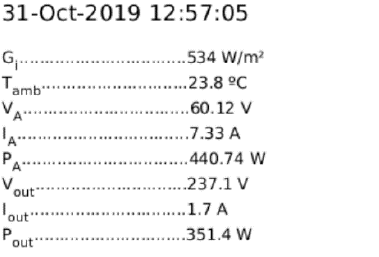
Table 4. Study of uncertainty.